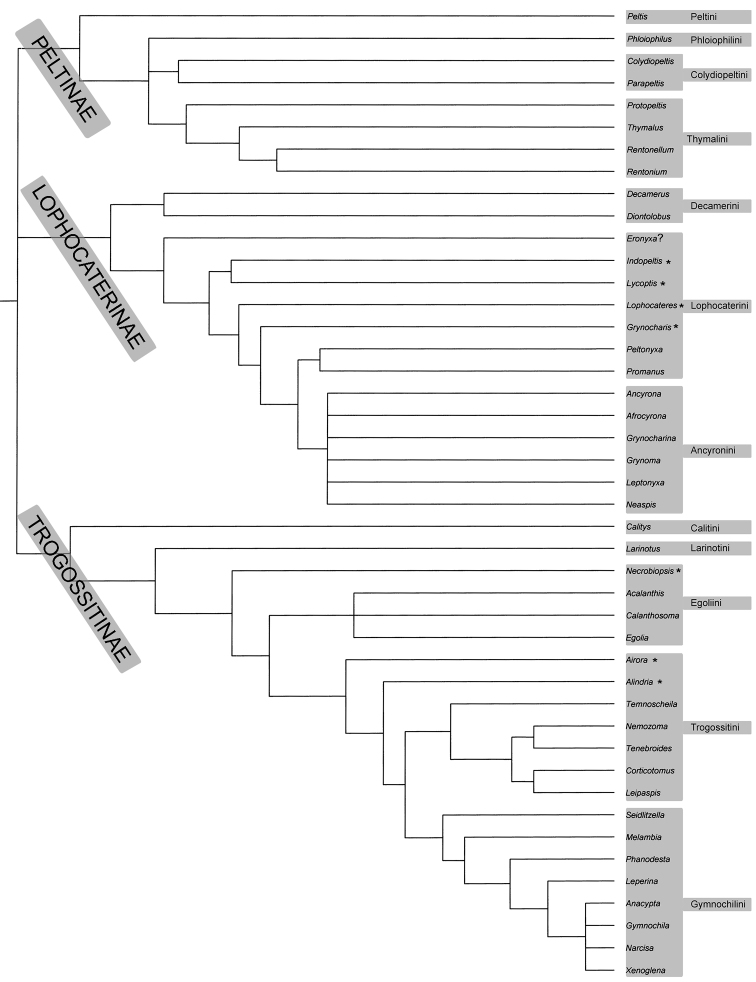
A phylogenetic tree of Trogossitidae adapted and modified from original drawing by Kolibáč (2008). Paraphyletic taxa denoted with the asterisk. Published with kind permission of Pro Entomologia, Basel, a publisher of Entomologica Basiliensia et Collectionis Frey.